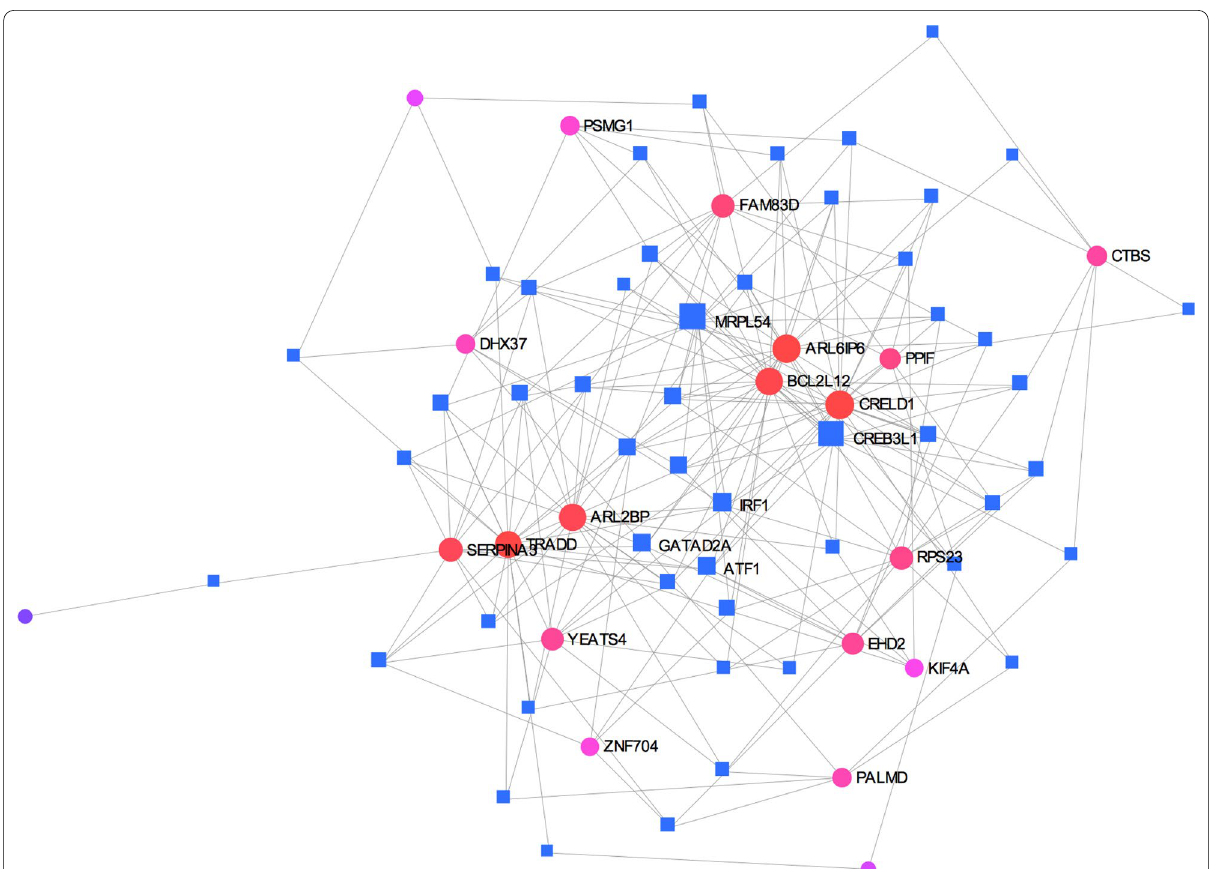
Fig. 4 Gene-TFs network analysis for identified significant DEGs The identified DEGs are illustrated by circles and associated transcription factors are presented by